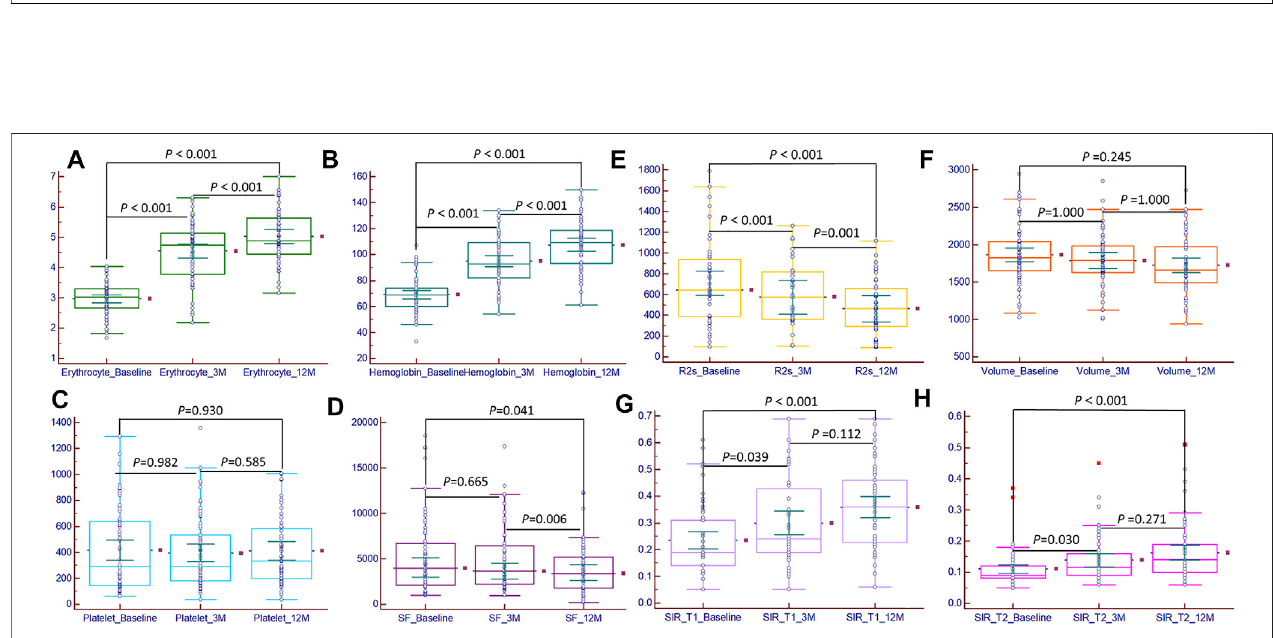
FIGURE3 | Bar chart ofmagnetic resonance imagingmetrics and clinical characteristics at baseline, 3 rd month, and 12th month. The erythrocyte (A) , hemoglobin (B) , hepatic muscle signal ratio (SIR)_T1 (G) , and SIR_T2 (H) signi fi cant increased ( p < 0.05); the platelet count (C) increased, but the difference was not signi fi cant ( p > 0.05); serum ferritin (D) and R2* (E) signi fi cant decreased ( p < 0.05); the liver volume (F) decreased, but the difference was not signi fi cant ( p > 0.05).